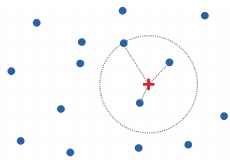
Figure 2. Diagram of k-Nearest Neighbours